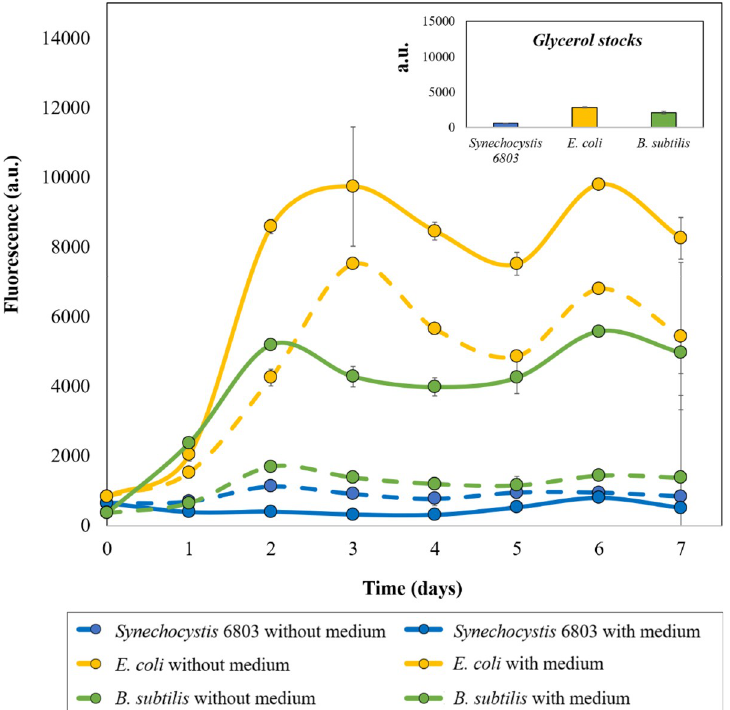
Fig 1. Effect of ultra-low temperature (ULT) storage on bacterial cell membrane integrity. The cells stored over a period of 7 days at ULT were subjected to a PI assay. Actively growing bacterial cell membranes pose a barrier for PI entry within the cell, however it can penetrate through membrane compromised or dead bacterial cells and intercalate within their polynucleotides yielding active fluorescence. Our results clearly indicated that with increased storage at ULT, bacterial cell envelopes were damaged, thereby increasing PI entry within the cells and hence increased fluorescence. Highest damage was observed in E . coli cells, followed by B . subtilis and Synechocystis 6803. Also, cells stored with the medium displayed higher fluorescence than the cells stored without the culture medium. Data are shown as mean ± S.D, n = 3.